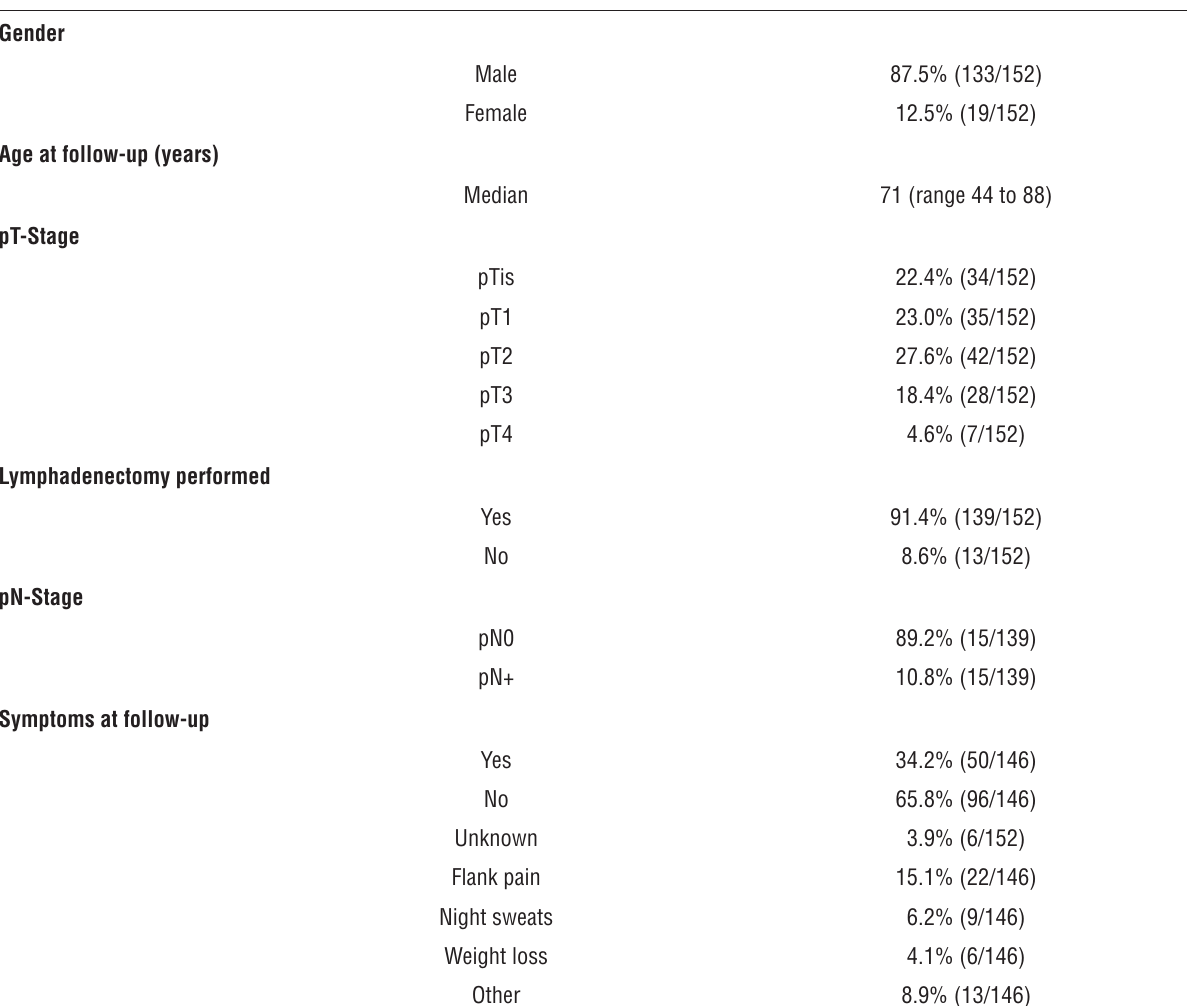
Table 1 - Baseline patients characteristics, histopathologic results, and stated symptoms following radical cystectomy and orthotopic urinary diversion after a median follow-up of 48